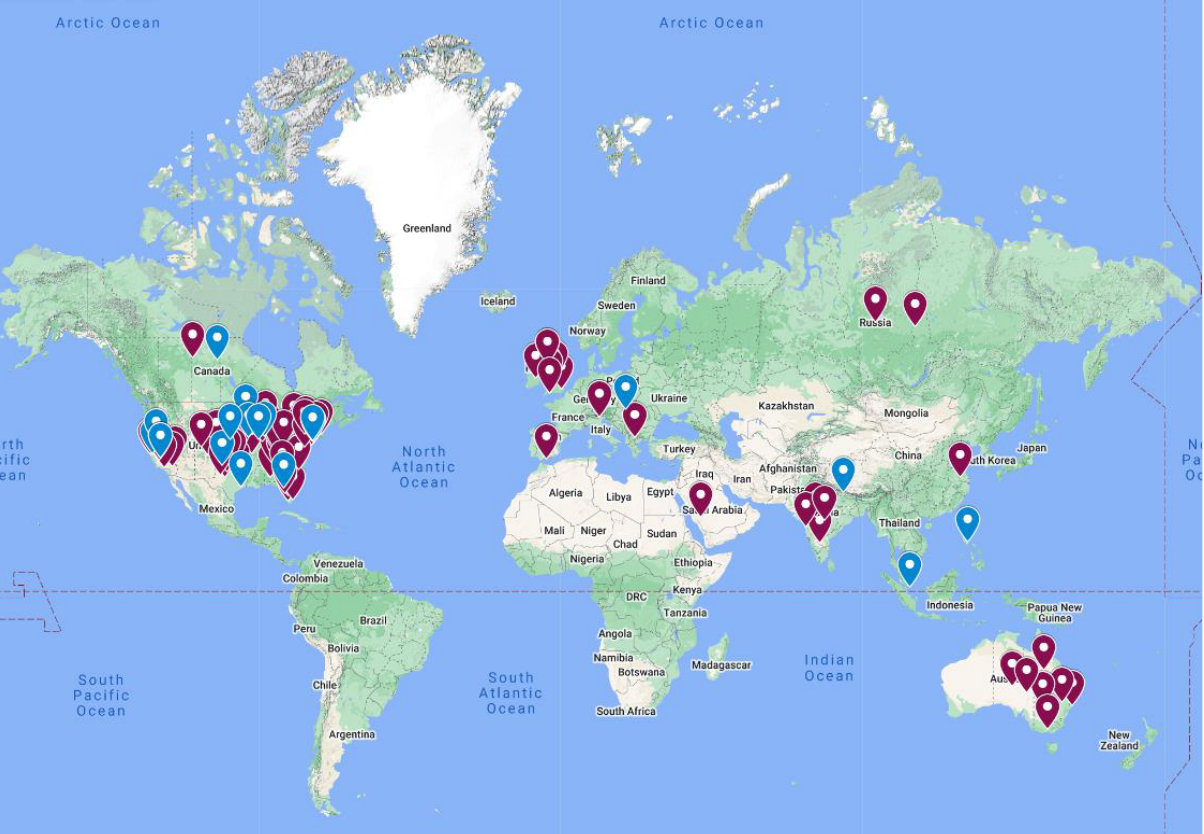
Figure 2. A map of 91 children (red dots) and 20 adults (blue dots) who informed us by email (via parents for children) of cough cessation from watching the video of a girl with chronic daily cough successfully stopped by suggestion therapy.